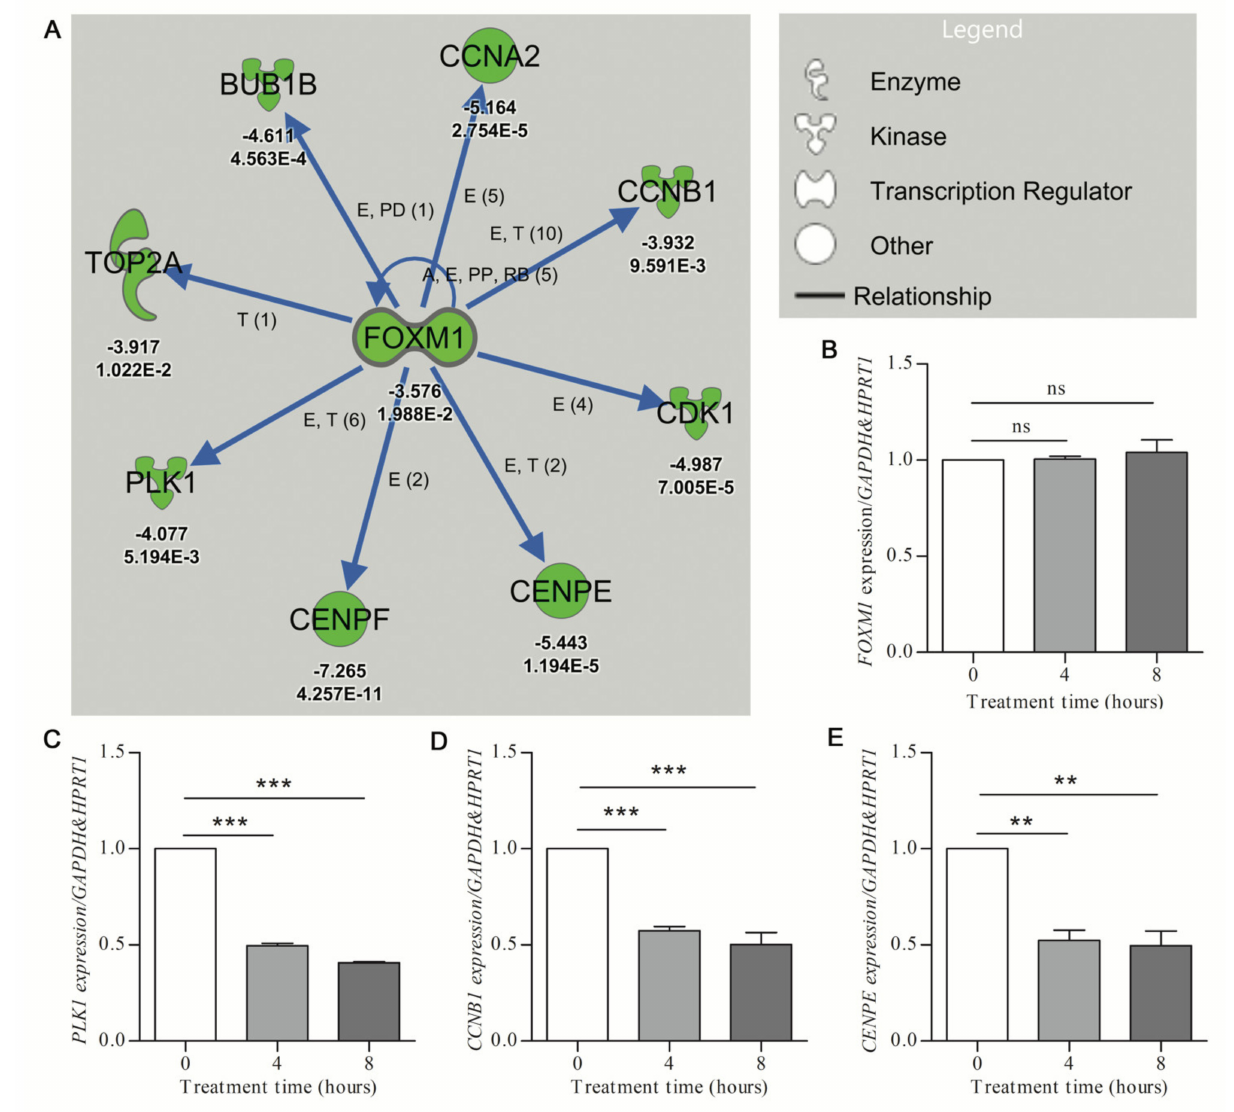
Figure 2. Validation of downregulated gene expression prioritized by IPA analysis. ( A ) The URA network shows down- regulation (green symbols) of the putative upstream regulator ( FOXM1 ) and the downstream molecules (with associated Z-score and p -value given under each gene, for p values, E-n symbolizes E -n )) (Care4Rare Neuron Screen). Blue arrows indicate inhibition of the physiological activating relationship between FOXM1 and related genes. Only genes for which p -adj < 0.05 are included. ( B–E ) U87 glioblastoma cells were treated with 250 µ M hydroxyurea for 0, 4, and 8 h. qRT-PCR ( n = 3) was employed to determine target gene expression with geometric normalization against GAPDH and HPRT1 . ( B ) Fork-head box M1 ( FOXM1 ). ( C ) Polo-like kinase 1 ( PLK1 ). ( D ) Cyclin B1 ( CCNB1 ). ( E ) Centromere protein E ( CENPE ). Statistical significance was measured by one-way ANOVA (nonparametric) with Tukey post hoc analysis (** p < 0.01, *** p < 0.001, ns =